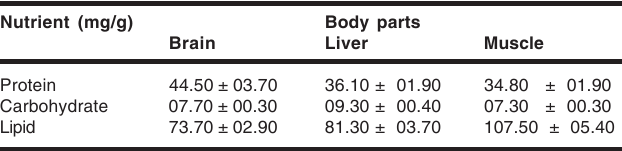
Table 6. Nutrient contents (mg/g) of the brain, liver and muscle of M. booduga Nutrient (mg/g) Body parts Brain Liver Muscle